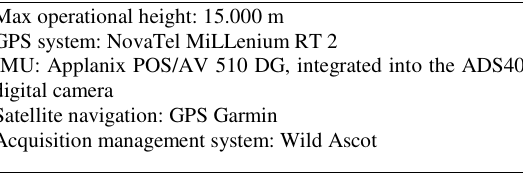
Table 1. Lear Jet 25C platform characteristics